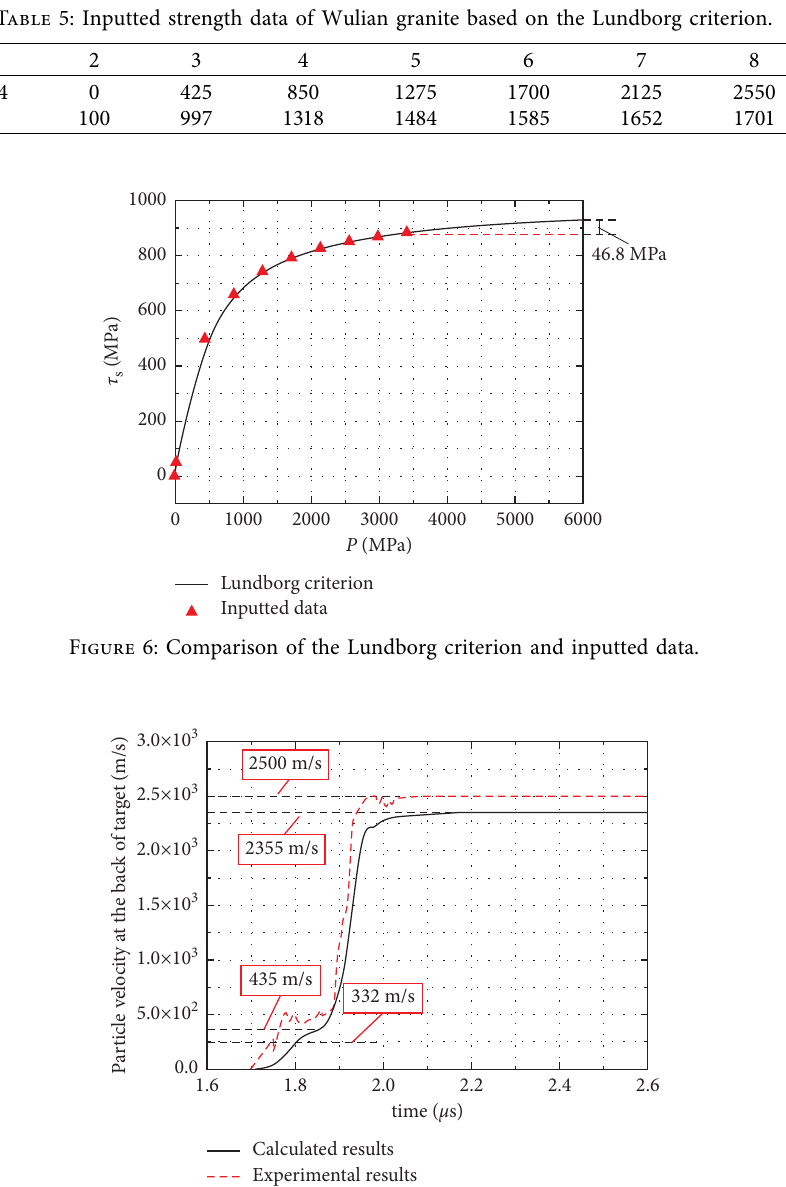
Figure 7: Comparison of particle velocity profiles from simulation and